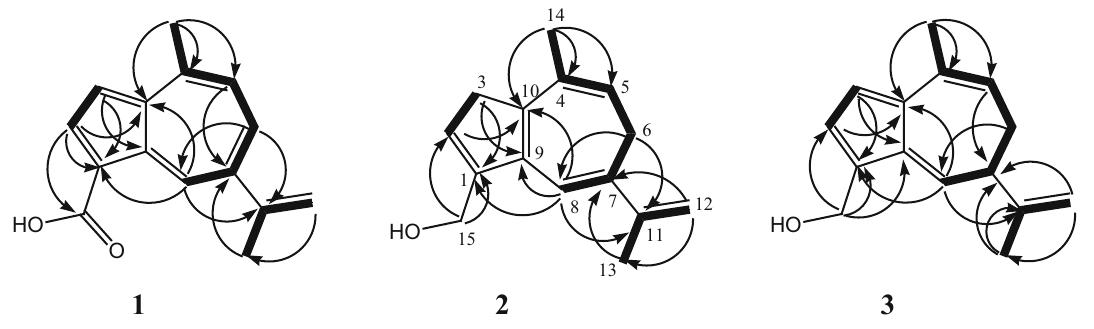
Fig. 2 Key HMBC ( arrows ) and COSY ( bold bonds ) correlations for compounds 1 –